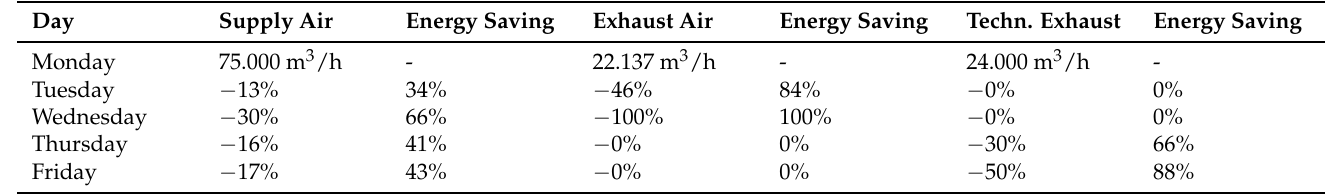
Table 1. Parameters for the experiments in winter and summer with the theoretical electricity savings.